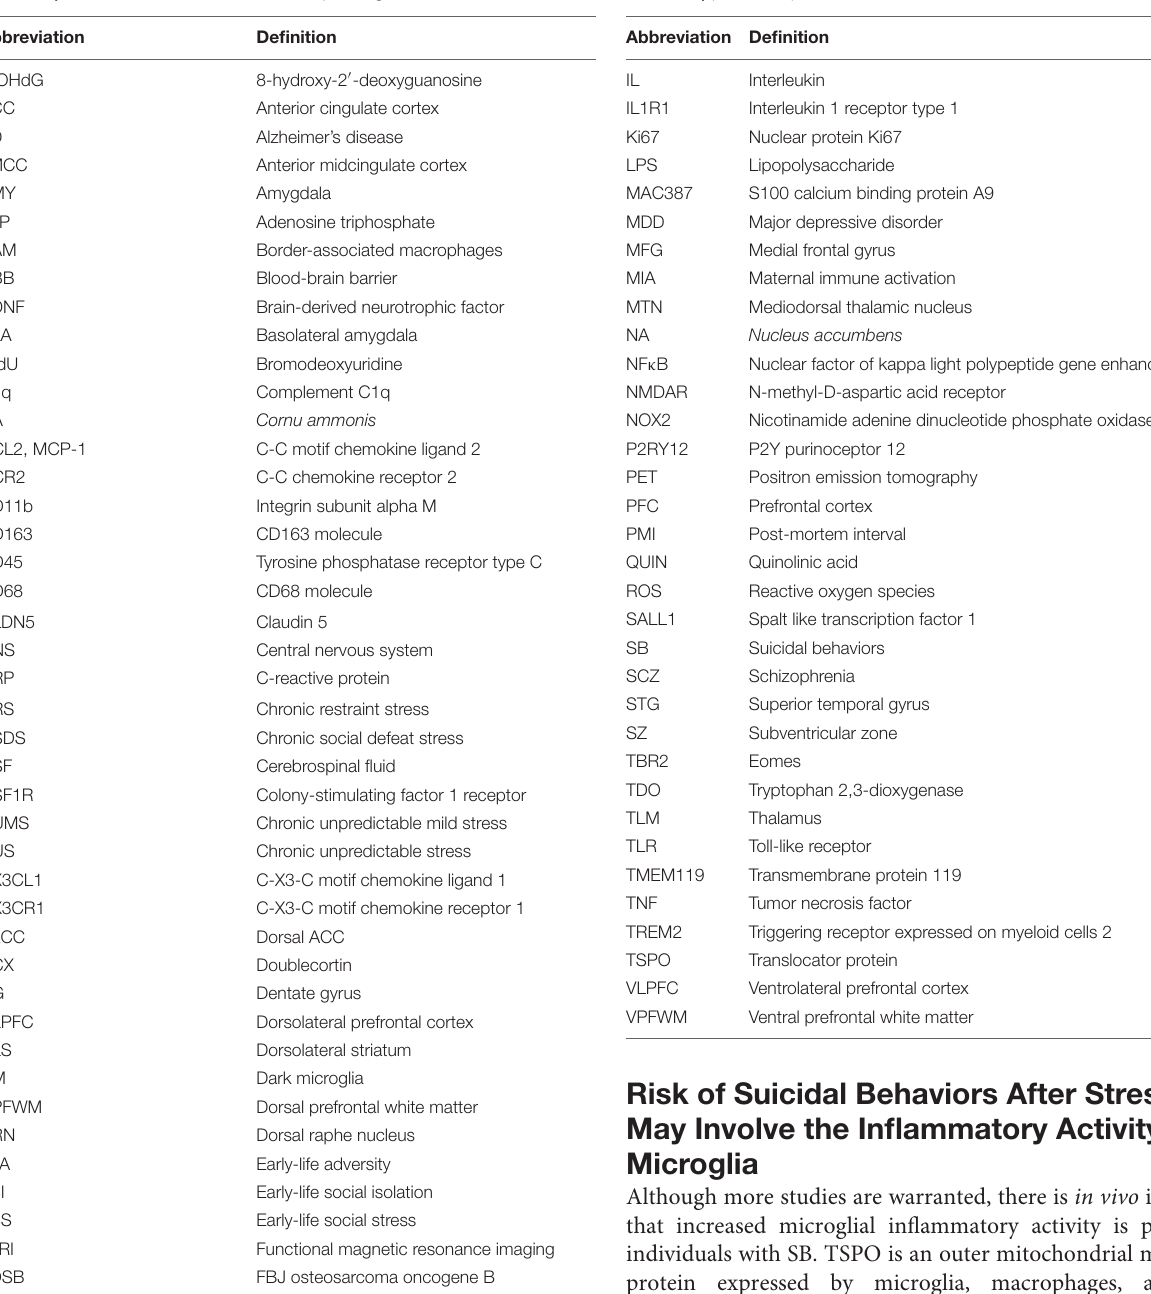
TABLE 1 | Full list of abbreviations and corresponding